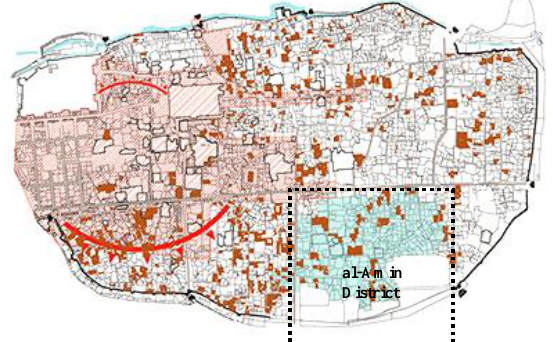
Figure 4. Plan of problems in the Old City, MAM project, 2008.